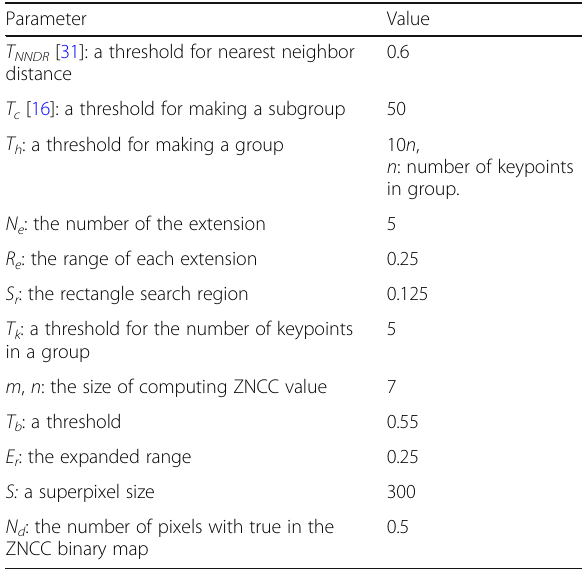
Table 3 Detected results for D0 dataset under simple copies